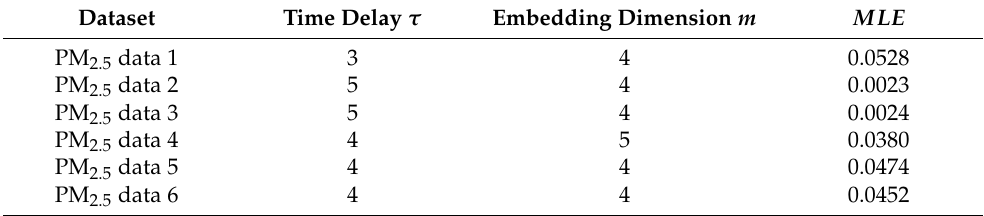
Figure 4. Relationship between the mutual information (MI) and time delay and between the false nearest-neighbour (FNN) rate and the embedding dimensions for a PM 2.5 concentration time series. Table 2. Resulting time delay, embedding dimensions and maximum Lyapunov exponent (MLE) of the PM 2.5 concentration time series for phase space reconstruction (PSR).